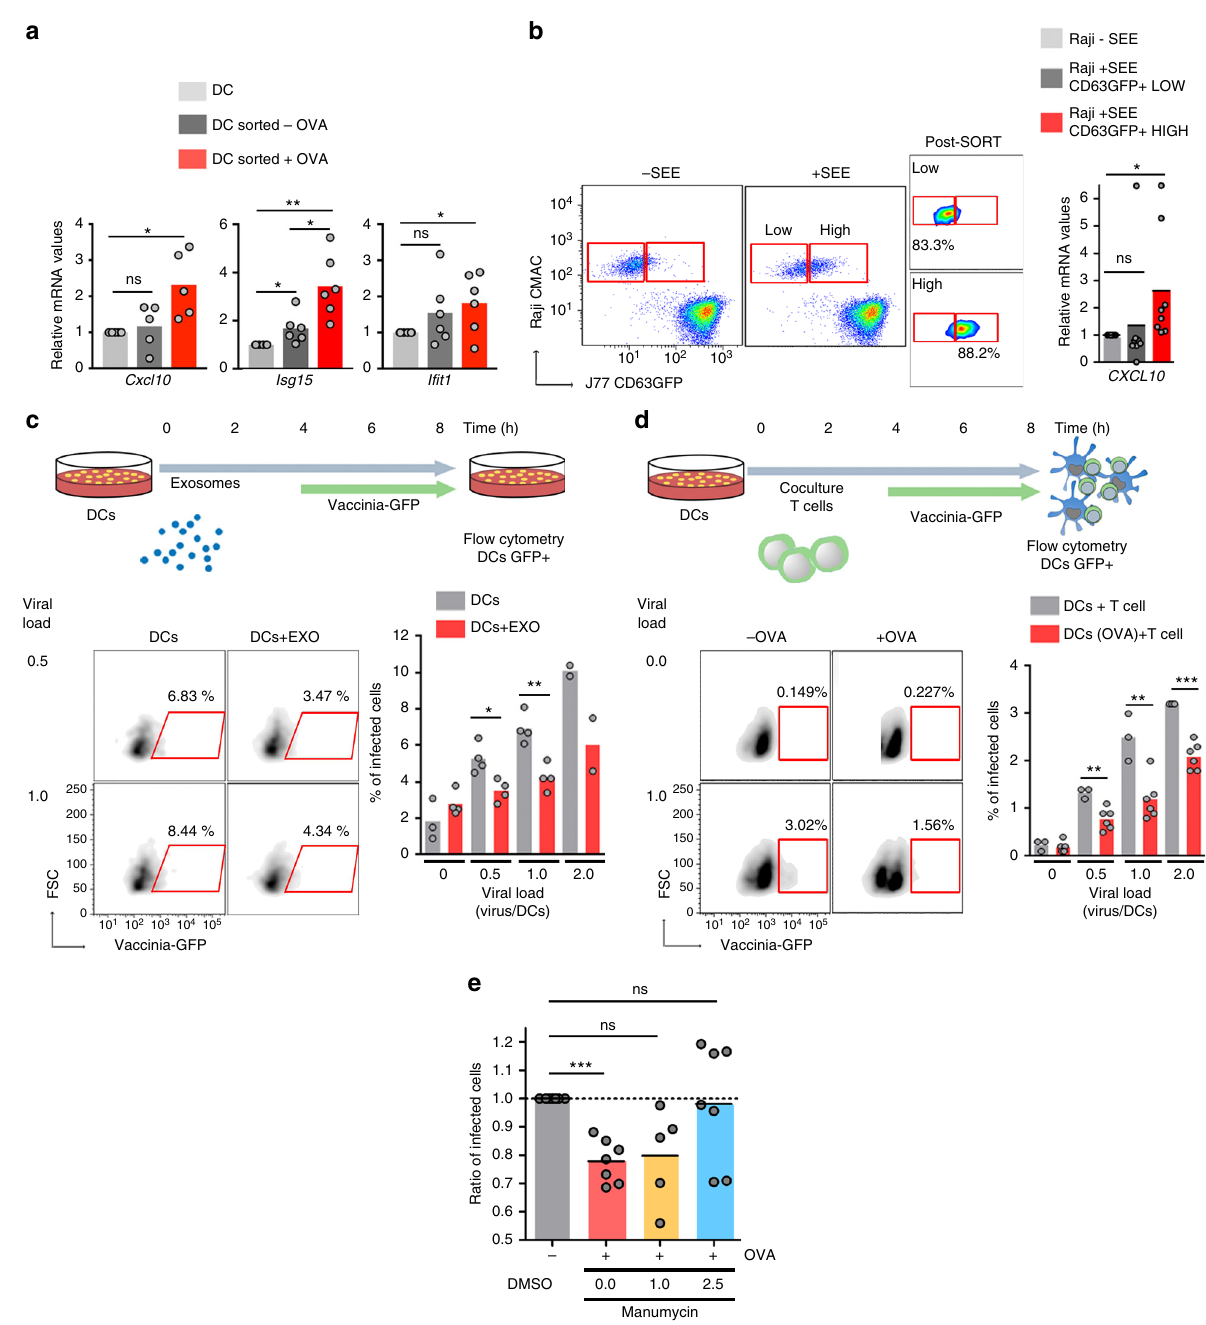
Fig. 6 Antigen-driven immune interactions prime DCs to pathogen infection. a qRT-PCR analysis of the DC antiviral response upon antigen-dependent contacts. Gene expression was analyzed in sorted DCs after 16h conjugate formation. Data shows mean from fi ve independent experiments. t -test * P -value< 0.05. b Left: Flow cytometry analysis of exosome uptake after co-culture of J77 T cells stably expressing CD63GFP with unprimed or SEE-primed Raji B cells. After immune interactions, Raji B cells (CMAC) were sorted according to the level of exosome uptake (CD63GFP content). Dot plots show the GFP signal in pre-sort and post-sort Raji populations. Right: Chart shows qRT-PCR analysis of Cxcl10 in low and high exosome uptake SEE-primed Raji B cell populations. Mean; n = 3. t -test * P -value<0.05. c Upper panel: Time fl ow for the analysis of exosome-mediated antiviral protection. DCs were incubated for 4h with T cell exosomes, infected with vaccinia-GFP, and analyzed for the level of infection by fl ow cytometry. Lower left: Dot plots of DCs infected with vaccinia-GFP with or without exosome pre-treatment. Lower right: Percentage of infected DCs at different viral loads with or without exosome pre-treatment. Mean; n = 4; t -test * P -value<0.05, ** P -value<0.01. d Upper panel: Time fl ow for the analysis of exosome-mediated antiviral protection after immune cognate interactions. Unloaded or OVA peptide-loaded DCs were incubated for 4h with CD4 + OT-II T cells, infected with vaccinia-GFP, and analyzed for the level of infection by fl ow cytometry. Lower left: Dot plots of DCs (gated on CD11c) infected with vaccinia-GFP in the presence or absence of OVA peptide. Lower right: Percentage of infected DCs at different viral loads in the presence or absence of antigen-dependent immune contacts. Mean; n = 3 – 6; t -test * P -value< 0.05, ** P -value< 0.01, *** P -value< 0.0001. e Unloaded or OVA peptide-loaded DCs were incubated for 4h with CD4 + OT-II T cells pre-treated with increasing amounts of manumycin, infected with vaccinia-GFP, and analyzed for the level of infection by fl ow cytometry. Graph shows the ratio of infected DCs. Data ( b , c , d , e ) are Mean from quanti fi cation of fi ve to seven independent experiments: t -test * P -value<0.05, ** P -value<0.001, and *** P